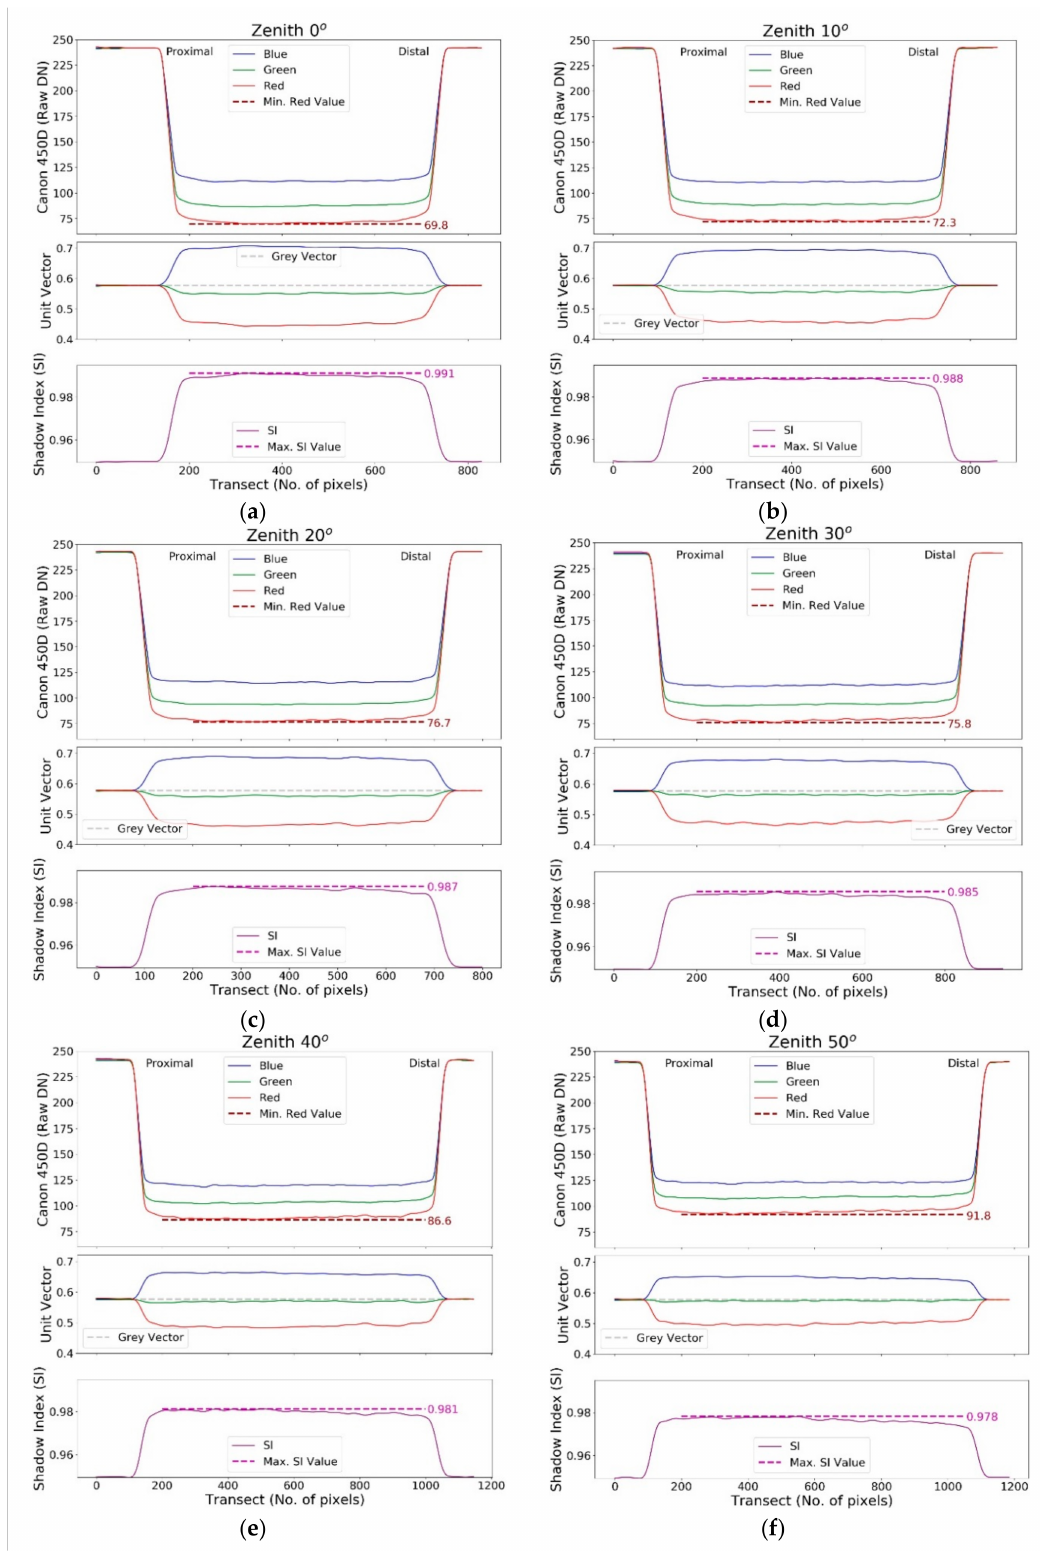
Figure 11. Canon 450D shadow transects showing raw DN, unit vector normalisation, and SI. Plates ( a ), ( b ), ( c ), ( d ), ( e ), and ( f ) are for zenith angles 0 ◦ , 10 ◦ , 20 ◦ , 30 ◦ , 40 ◦ , and 50 ◦ , respectively. In each raw DN transect, the minimum red band value is shown as a reference for brightness. In each unit vector transect, the grey vector is shown and for the SI transect, the maximum SI is the reference for changes in